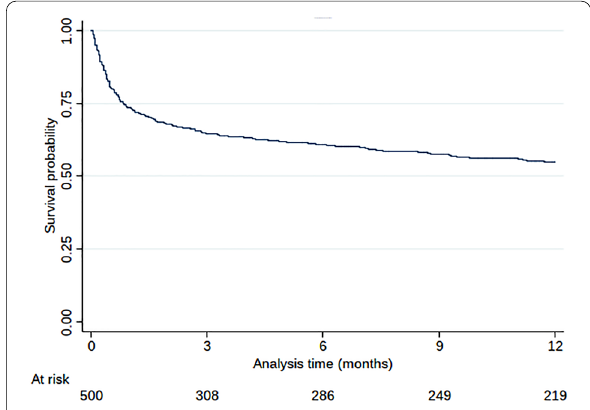
Fig. 2 Kaplan–Meier survival curve of the patients included in